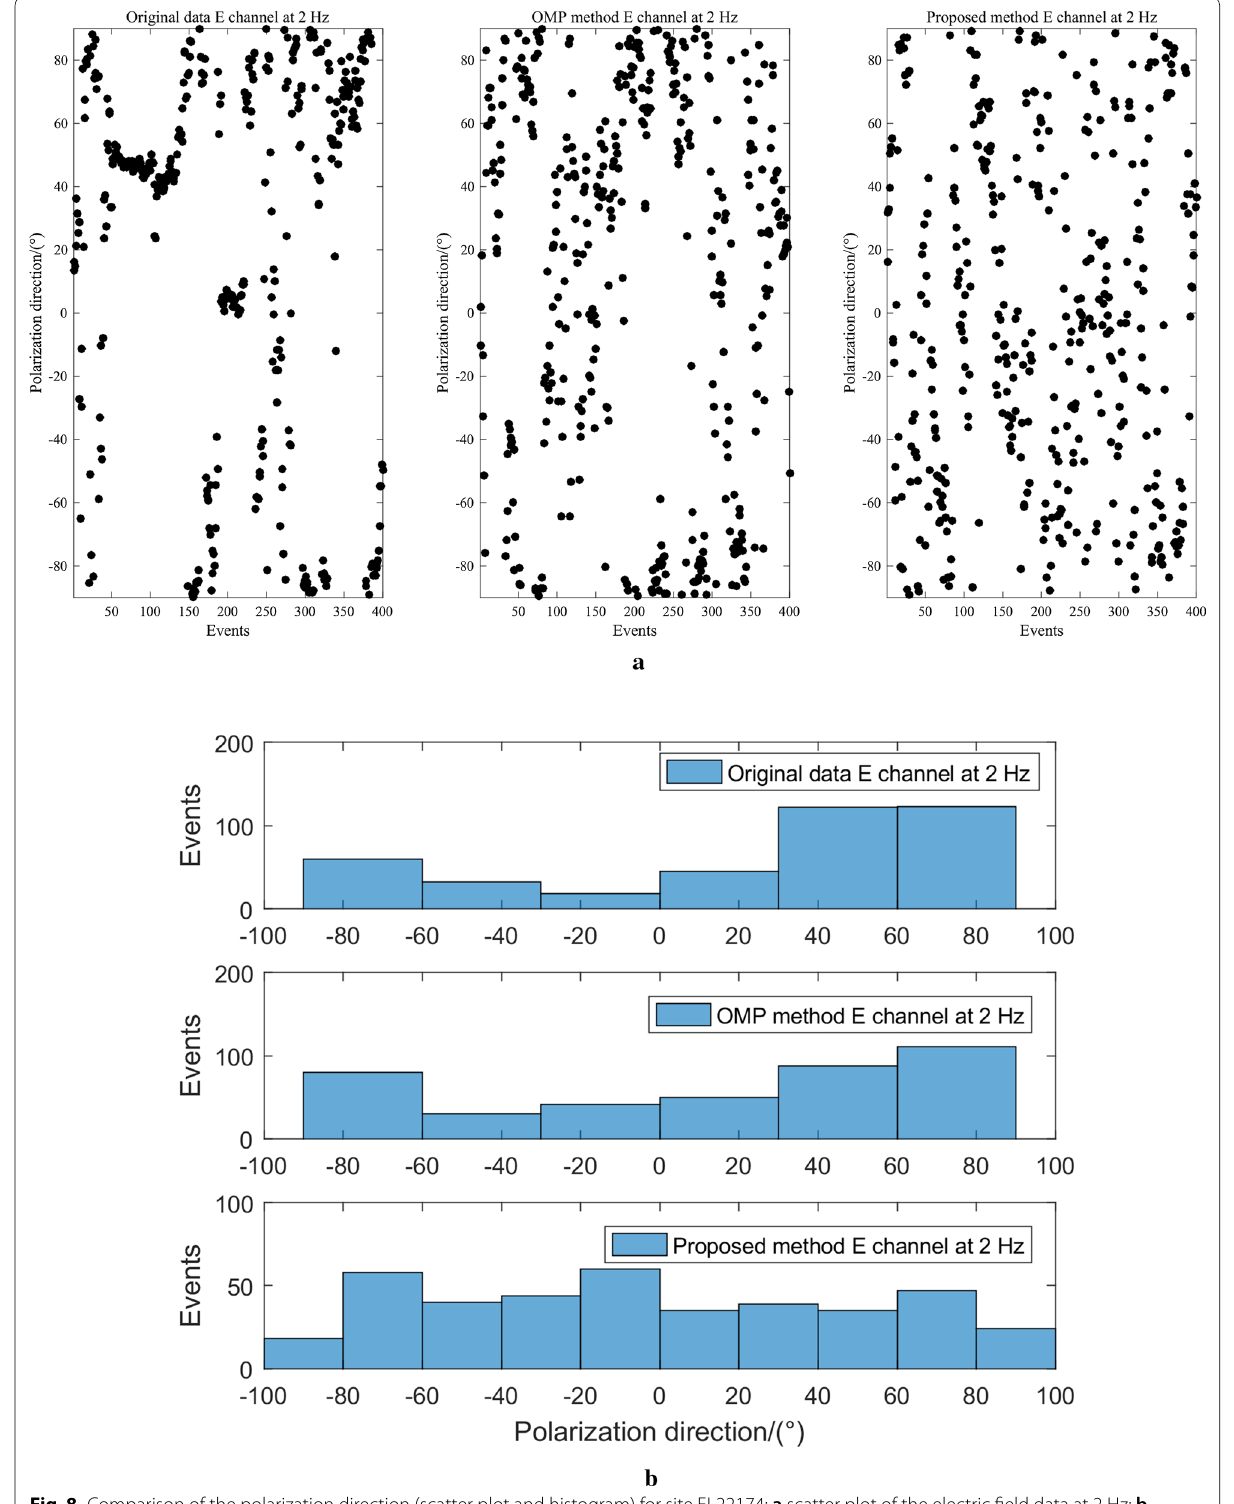
Fig. 8 Comparison of the polarization direction (scatter plot and histogram) for site EL22174: a scatter plot of the electric field data at 2 Hz; b histogram of the magnetic field data at 2 Hz; c scatter plot of the electric field data at 4.2 Hz, and d histogram of the magnetic field data at 4.2